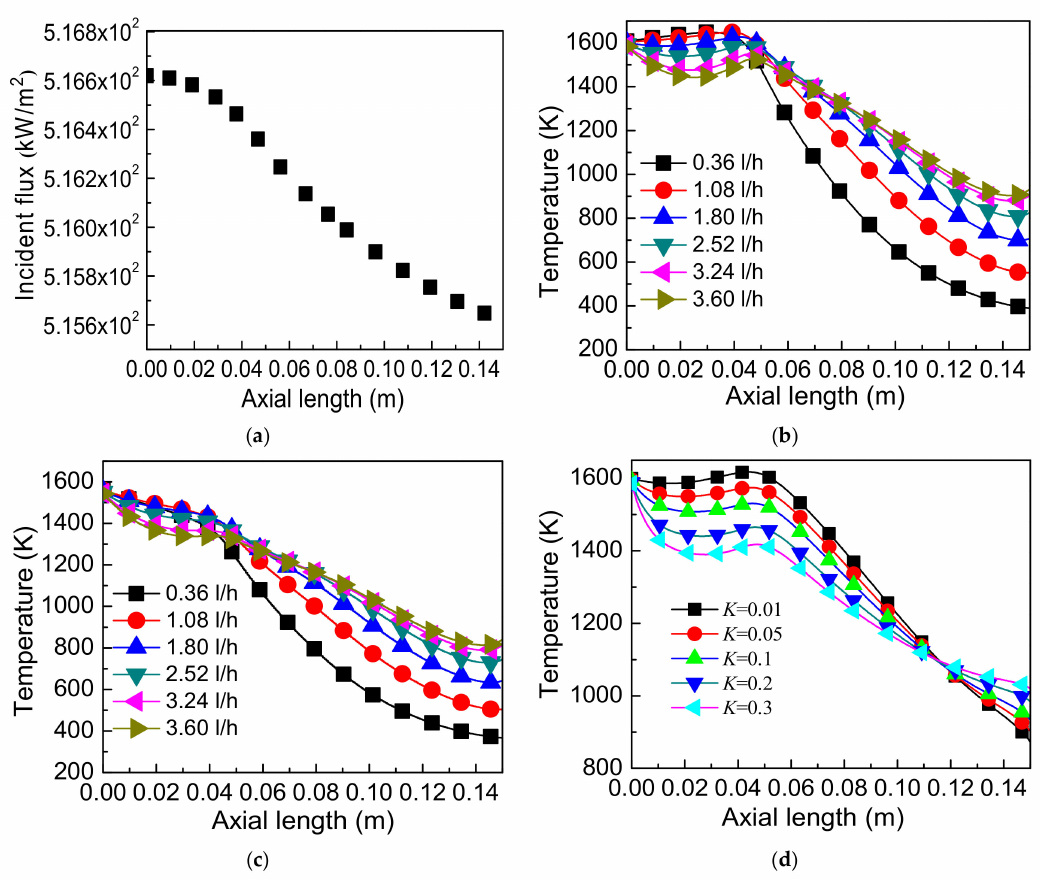
Figure 8. The distribution flux along the reactor at 150 kW / m 2 incident flux, 1 atm and 1.8 L / h inflow rate: ( a ) Incident heat flux distribution in the reactor at 1.8 L / h and K = 0.3; ( b ) Temperature distribution for flux applied on frustum edges KM and LN; ( c ) Temperature distribution for the flux applied at (GH) for di ff erent gas inflow rate; ( d ) Temperature distribution for di ff erent absorption coe ffi cient ( K